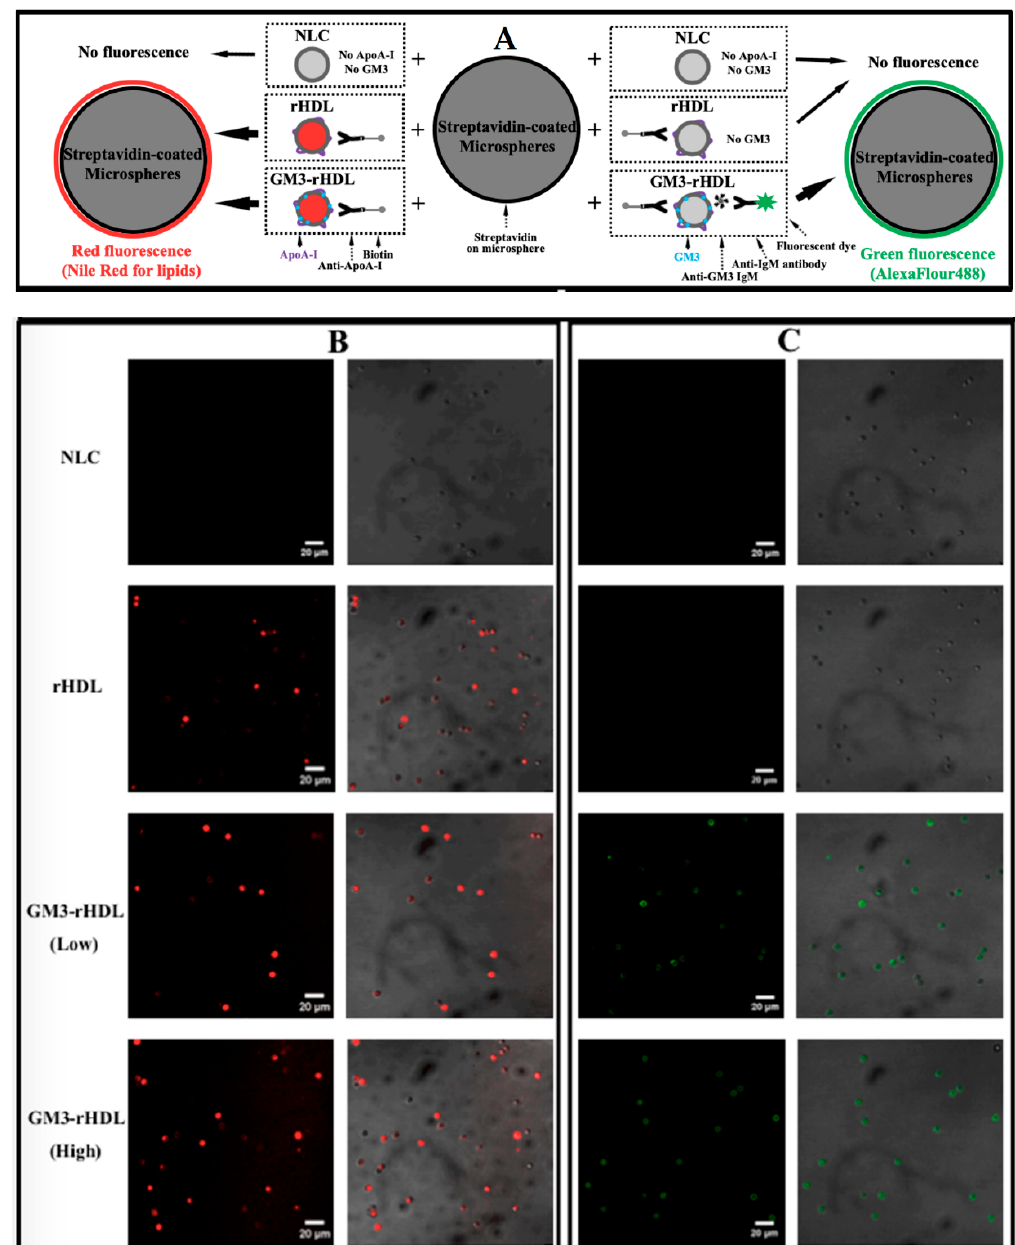
Figure 2. Validation of the presences of ApoA-I and GM3 in GM3-rHDL nanoparticles via a microsphere-based method. ( A ) Schematic diagram showing the microsphere-based method. The nanoparticles were reacted with anti-ApoA-I-biotin and subsequently conjugated with streptavidin-coated silica microspheres for the following validations via fluorescence staining and confocal microscopy. The validation of ApoA-I by Nile red staining is showed on the left and the validation of GM3 by staining with anti-GM3 IgM plus AlexaFlour488-conjugated anti-IgM 2nd antibody is showed on the right. ( B ) Representative confocal images of nanoparticles-bearing microspheres stained by Nile Red. ( C ) Representative confocal images of nanoparticles-bearing microspheres stained by AlexaFlour488. Panels from top to bottom: nanostructured lipid carrier (NLCs), rHDL, GM3 L -rHDL, and GM3 H -rHDL, respectively. Left panels: fluorescence images; right panels: the merged images from the fluorescence and DIC images.